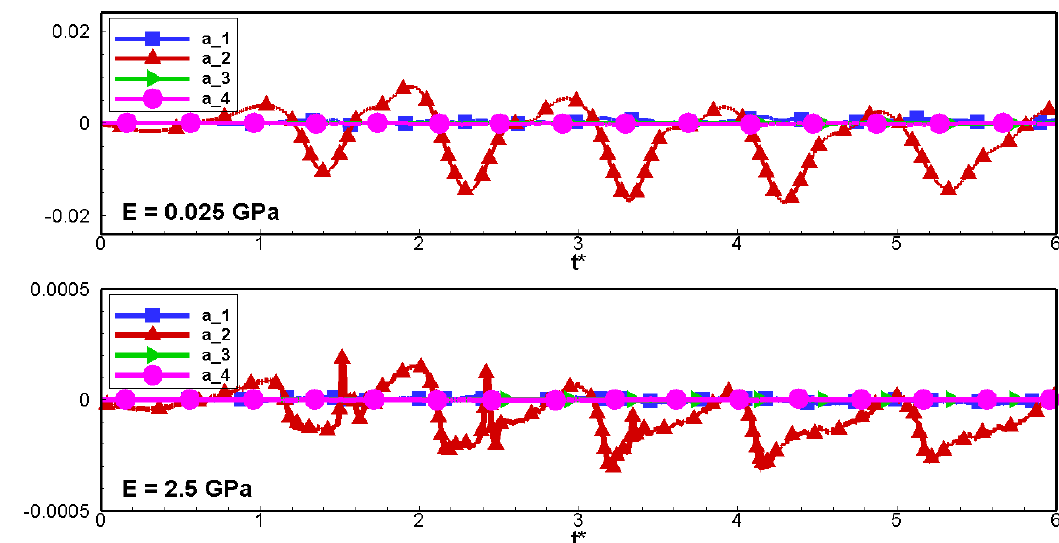
Figure 7. Amplitude of the vibration modes of the floating plate with Young modulus E = 250 MPa under less severe wave conditions with wave steepness ka = 0.295. Ratio of the plate length to the wavelength is 2 L / λ =